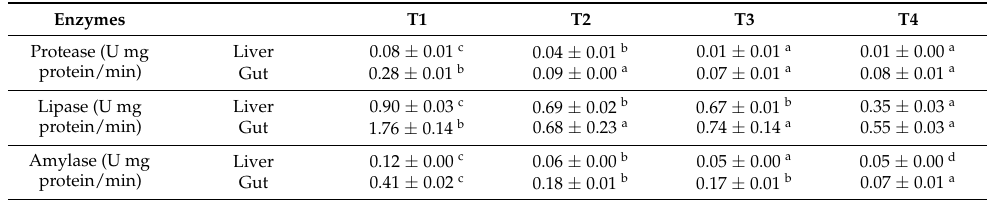
Table 3. Effect of stocking density on the digestive enzyme activities of O. bimaculatus seed reared in biofloc systems for 90